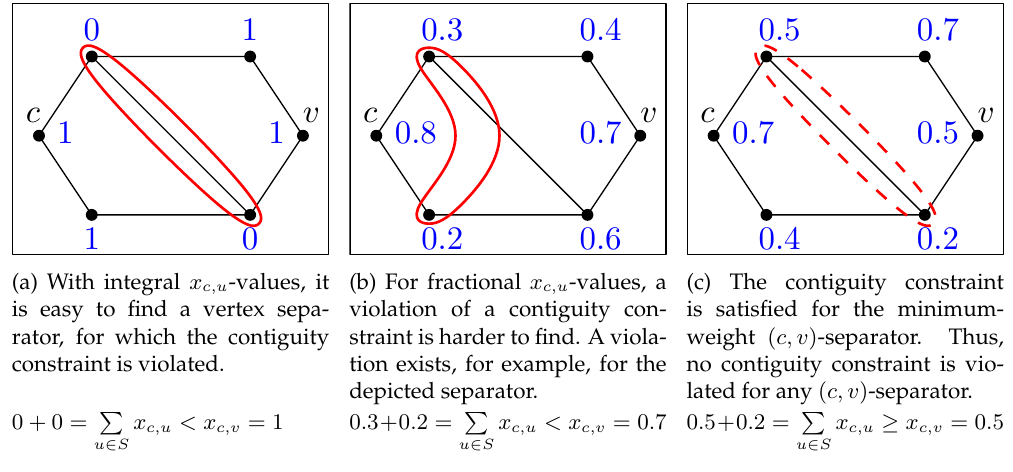
Figure 6: In this example with fixed c, v ∈ V , we examine the search for a ( c, v ) -separator, for which the contiguity constraint (Constraint (13)) is violated. For a vertex u ∈ V , we consider the value x c,u from the solution of an LP relaxation as its vertex weight (blue). It depends on these values whether a violation of a contiguity constraint exists. Separators which are interesting in this context are indicated in